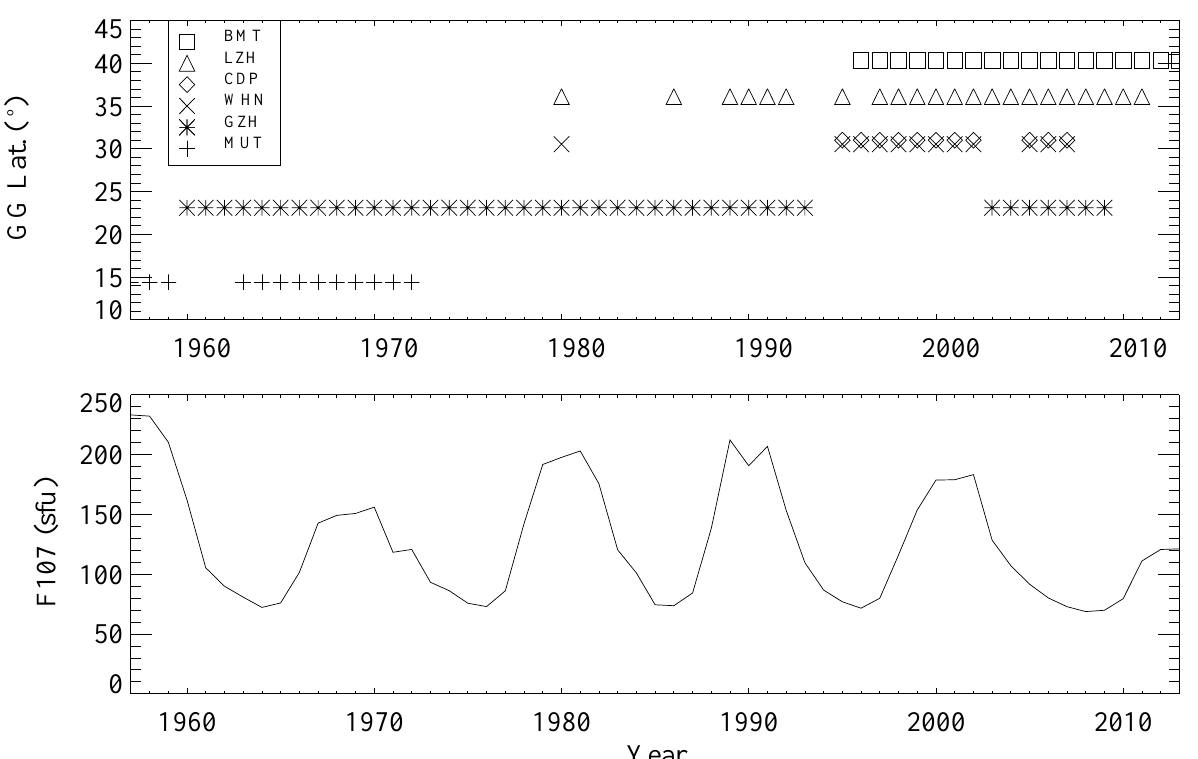
Figure 2. ( Top ): Yearly coverage of the observations used in this study at each observatory. ( Bottom ): Yearly averages of the 10.7 cm solar radio flux (F107) over the full time period (1957–2013), downloaded from the ftp server: ftp://ftp.gfz- potsdam.de/pub/home/obs/Kp_ap_Ap_SN_F107 (accessed on 18 September 2021).